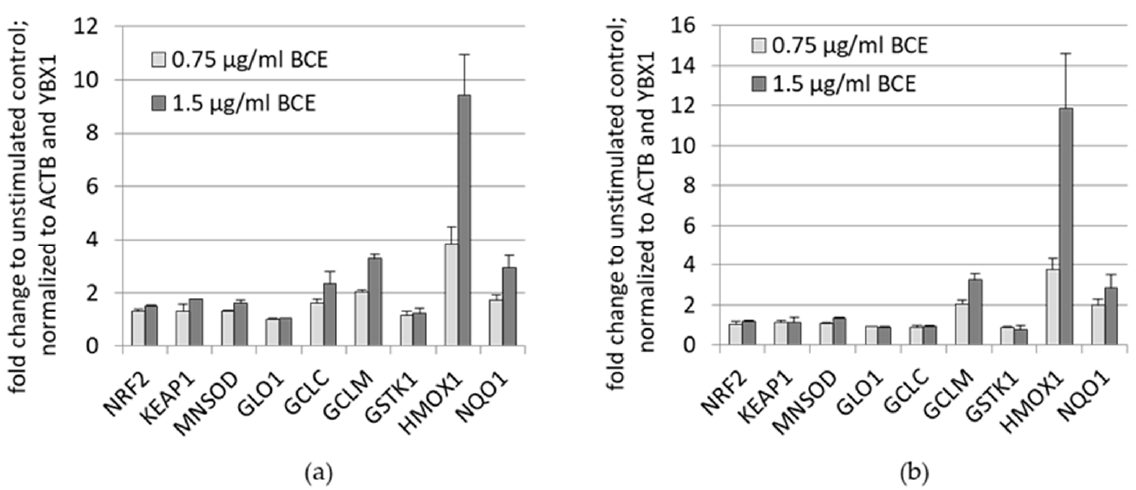
Figure 2. BCE increases antioxidant gene expression in HeLa and EA.hy926 cells. ( a ) HeLa, and ( b ) EA.hy926 cells were incubated with 0.75 µg/mL and 1.5 µg/mL BCE for 24 h. MRNA abundance of the indicated antioxidant genes was measured by quantitative real-time PCR (qRT-PCR) and normalized to reference genes (ACTB, YBX1). Data were analyzed from three independent experiments and depicted as means with standard deviation.